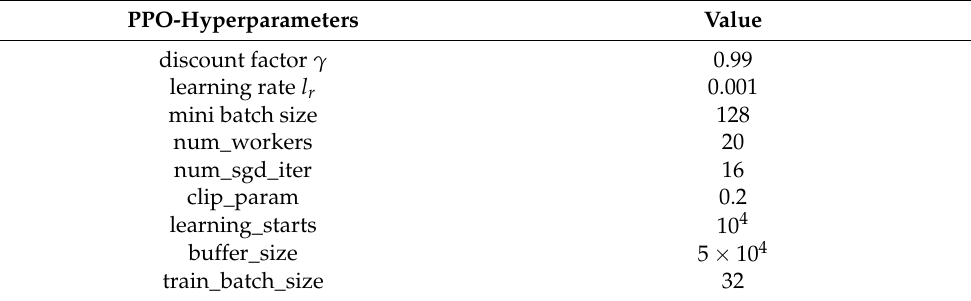
Figure 8. Mean reward vs. number of epochs for ( a ) environment 1, ( b ) environment 2, ( c ) environment 3, and ( d ) environment 4. Table 2. The list of hyperparameters used for training